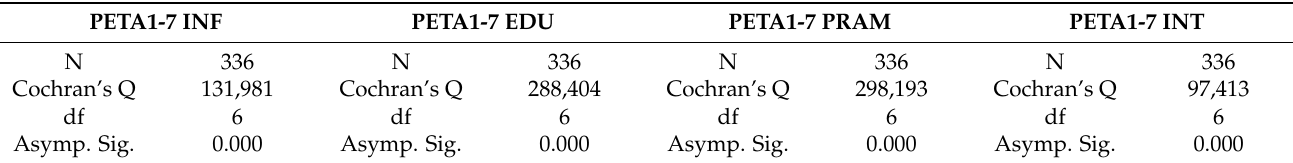
Table 3. The results of Qochran’s Q